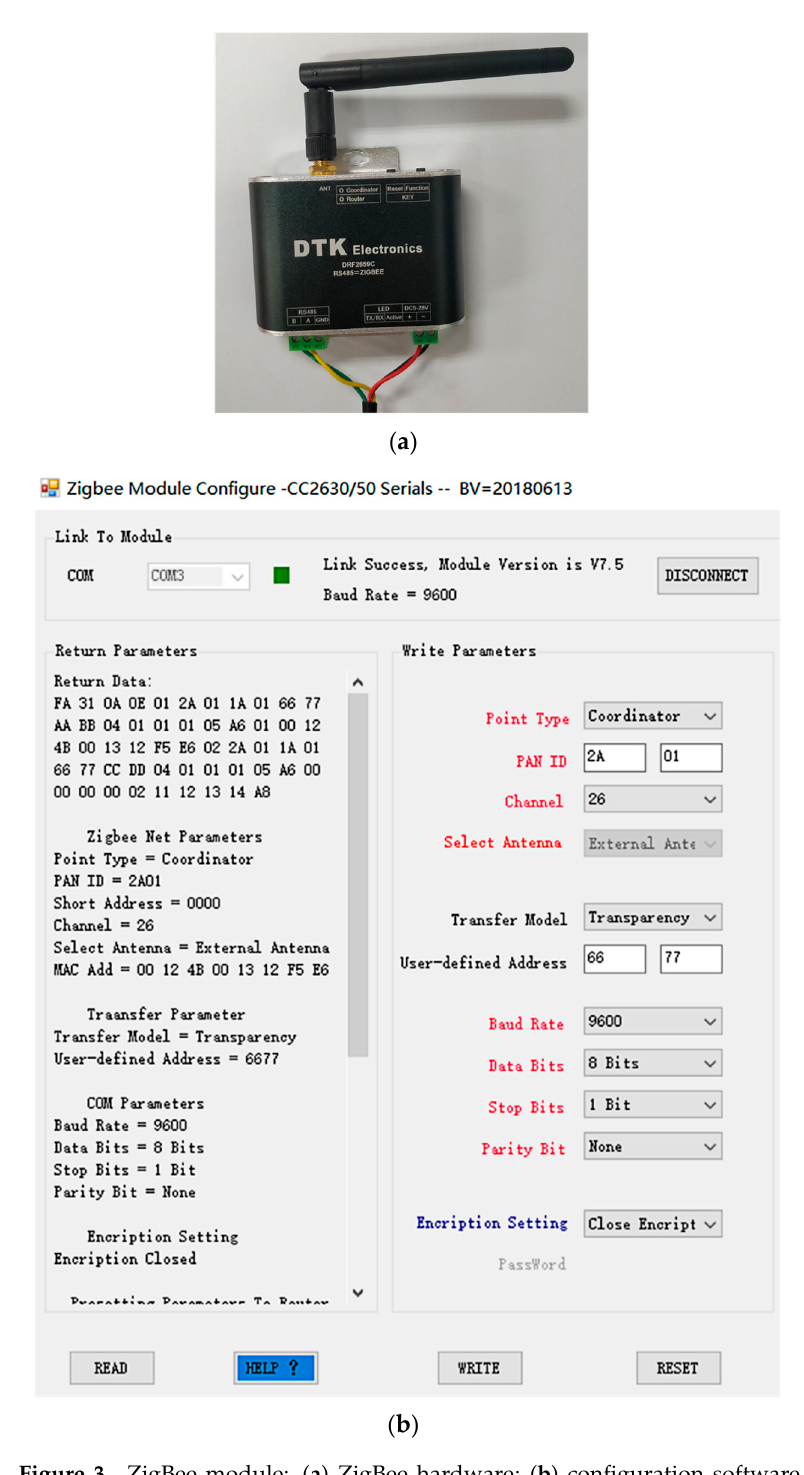
Figure 3. ZigBee module: ( a ) ZigBee hardware; ( b ) configuration software *. * location: http://www.dtkcn.com; company: DTK electronics ; version:V7.5.